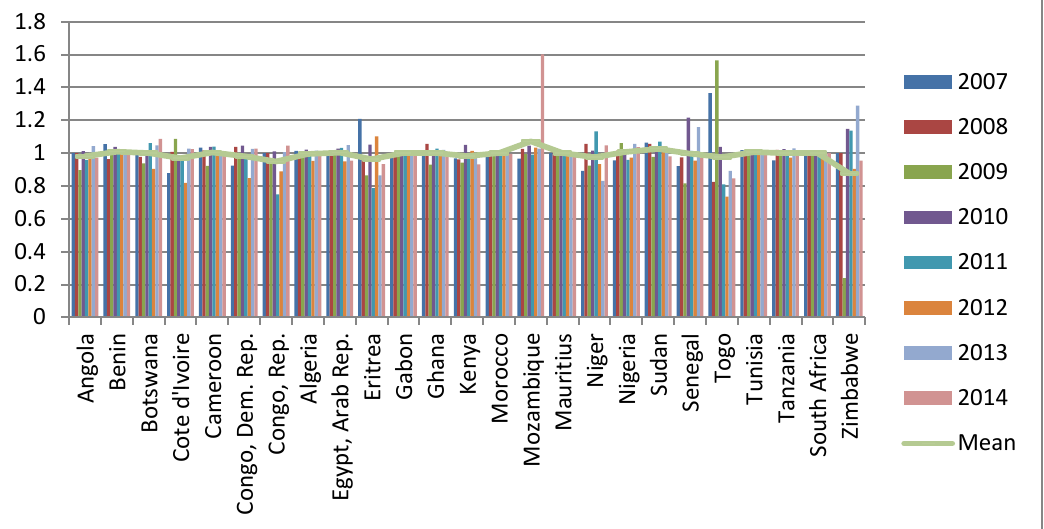
Figure 7. Comparison between average MPI energy efficiency with and without CO 2 emissions.